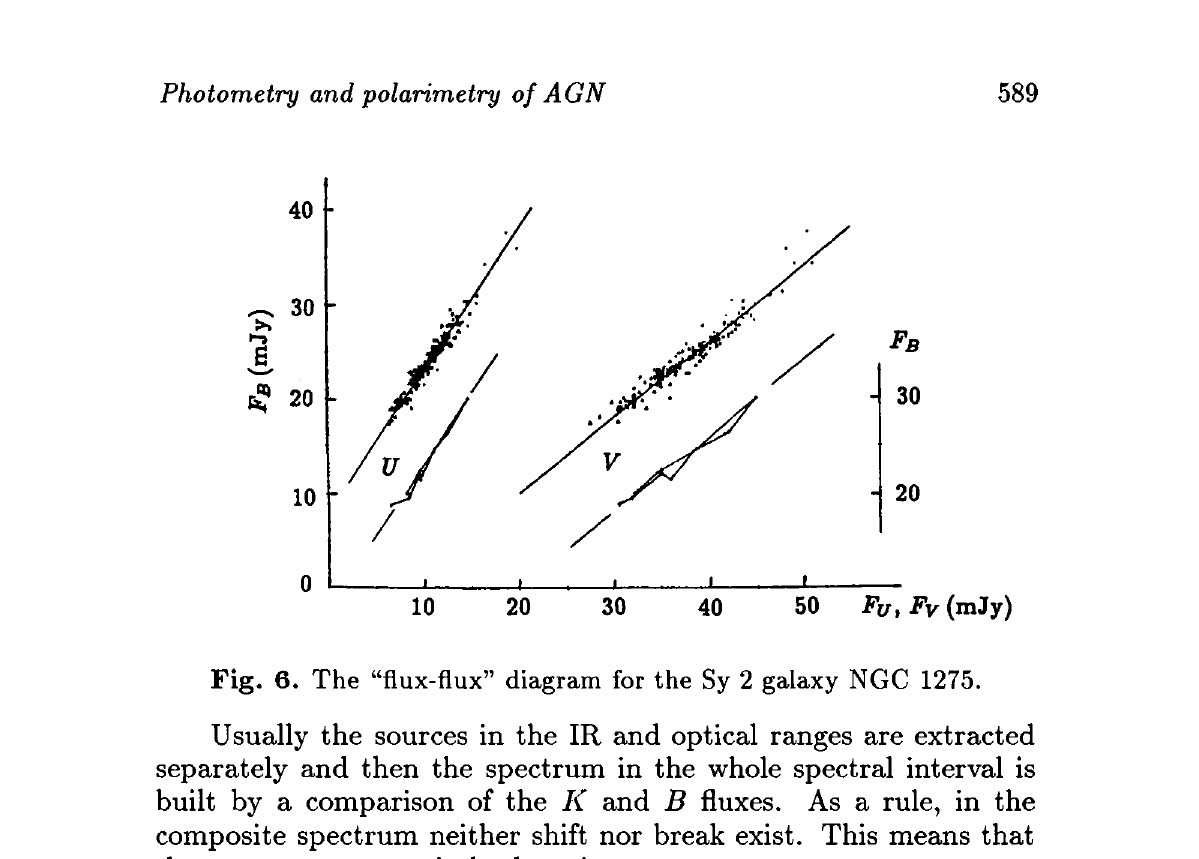
Fig. 6. The "flux-flux" diagram for the Sy 2 galaxy NGC